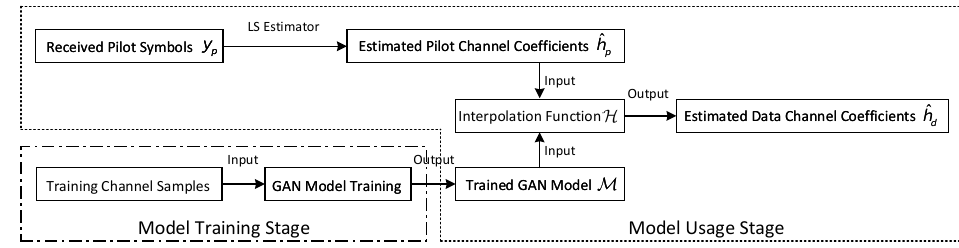
Figure 2. The procedure of the proposed GAN-based channel estimation